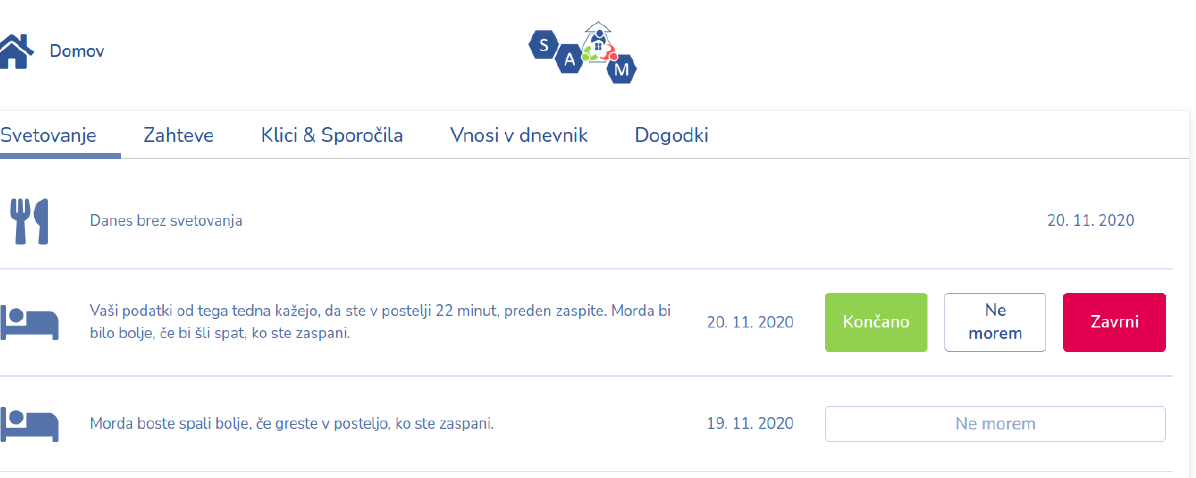
Figure 3. User interface of the SAAM coaching system (in Slovene) with the feedback buttons shown: green for accept , red for decline , and white for cannot perform